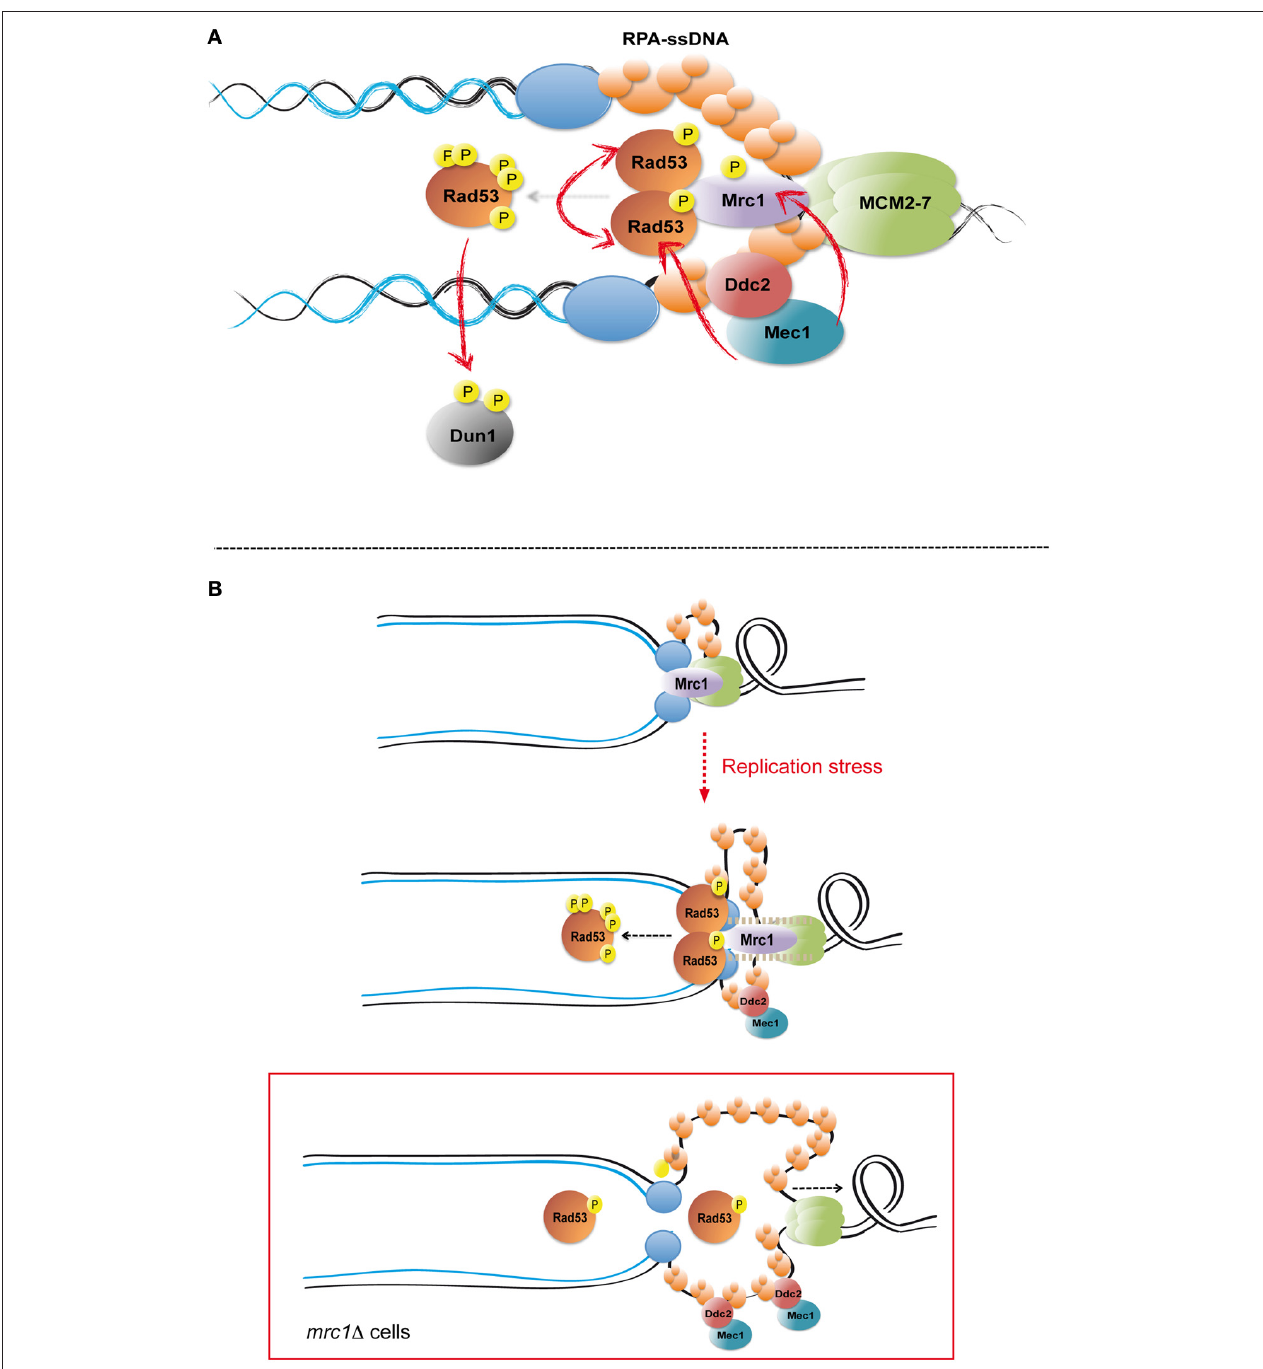
FIGURE 1 | Checkpoint activation in response to replication stress. (A) Upon replication fork stalling ssDNA is generated by the replicative helicase—DNA polymerases uncoupling. RPA-ssDNA mediates the recruitment of the apical checkpoint kinase Mec1 to replication forks by the action of its associated factor Ddc2. Mec1 phosphorylates fork components, including the Mrc1 transducer, and the Rad53 effector kinase. Mrc1 serves as a scaffold promoting Rad53 trans-autophosphorylation events and full kinase activation. Rad53 phosphorylates and activates the Dun1 effector kinase. Red arrows indicate key phosphorylation events mediating checkpoint activation. (B) Mrc1 is a replisome component that travels with replication forks in